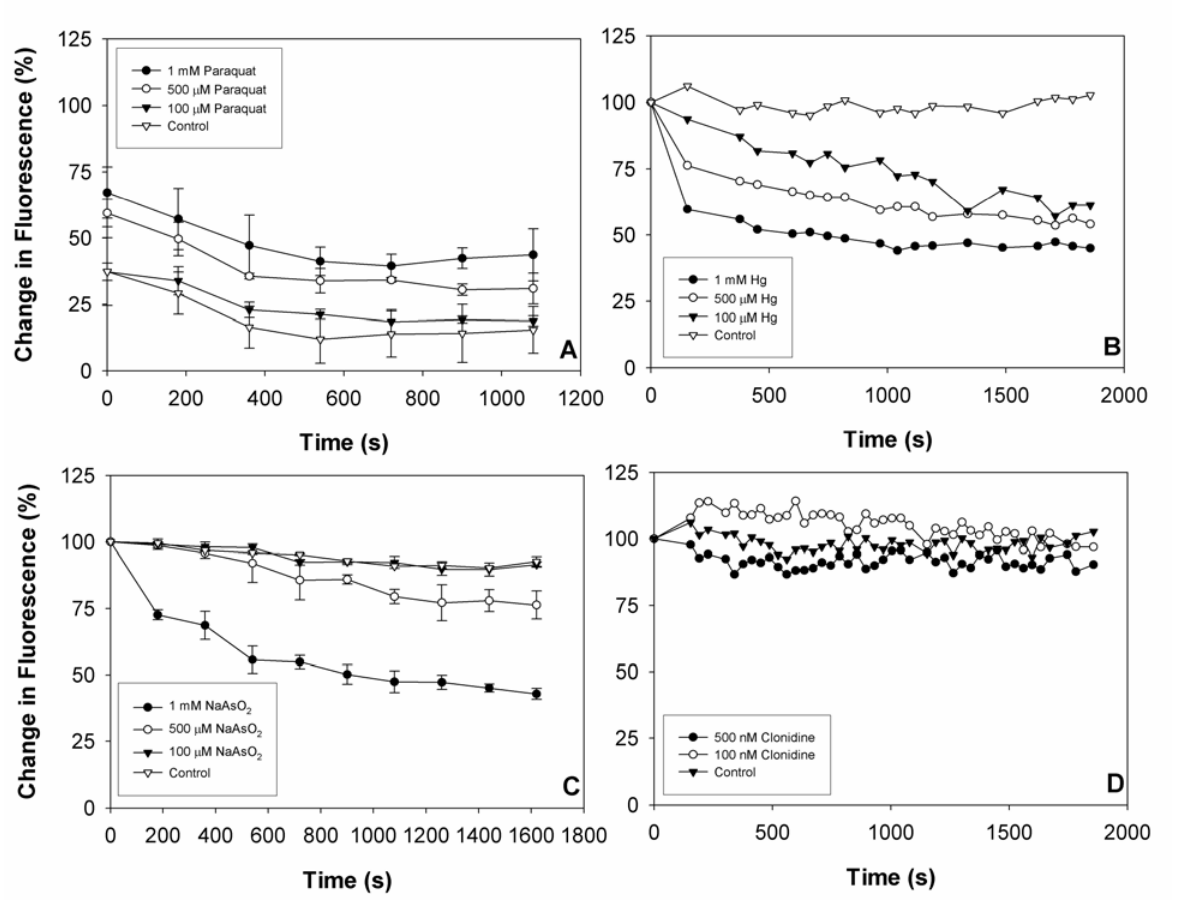
Figure 1. Representative algal cell responses to model compounds (A) Algae exposed to paraquat. Readings are shown are shown from time of light exposure. Light exposure prior to fluorescence detection is necessary for the peroxide production that represents the toxic ). (C) Algae exposed to sodium effect of paraquat. (B) Algae exposed to mercury (HgCl 2 arsenite (NaAsO ). (D) Algae exposed to 2